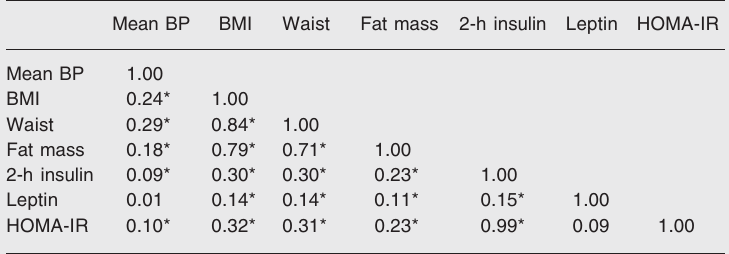
Table 2. Correlation coefficients between variables of main